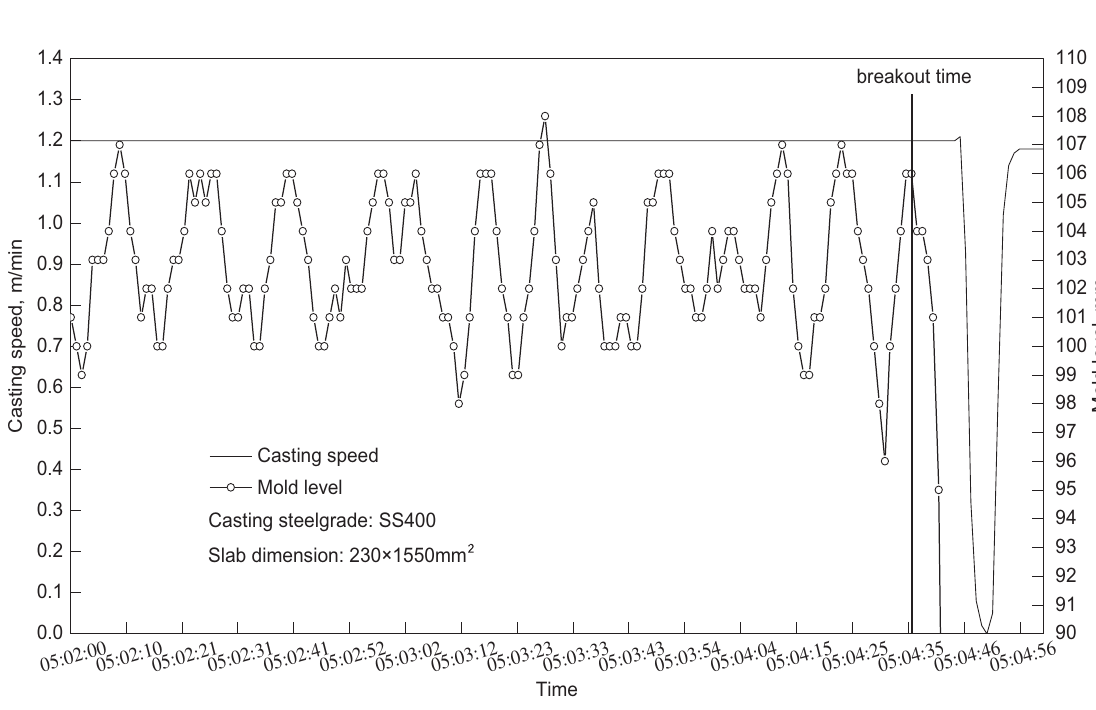
Figure 2: A sample of sticker caused by bigger liquid-level